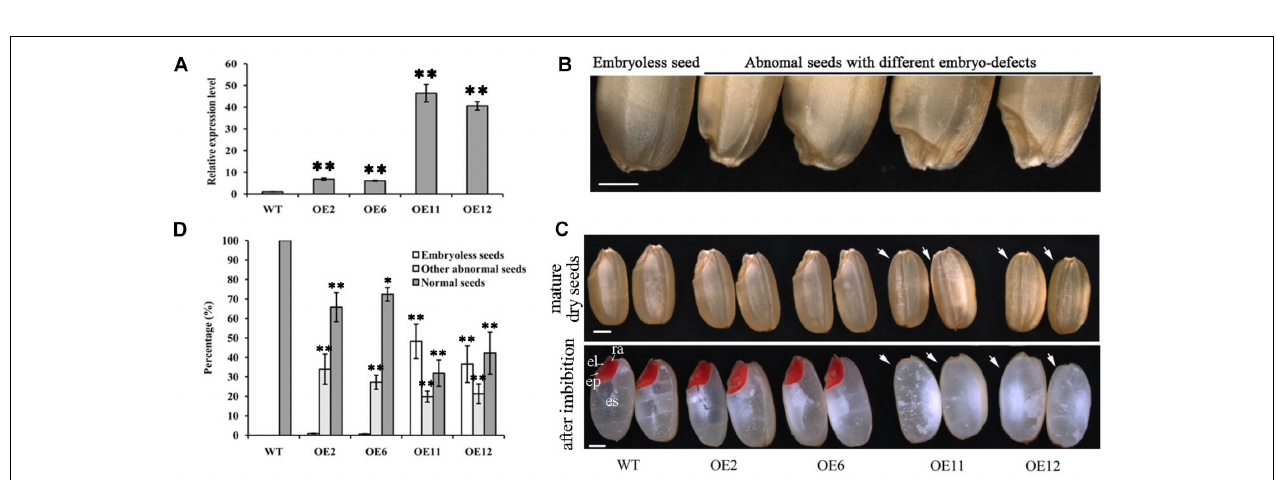
FIGURE 3 | Phenotypic analysis of seeds overexpressing OsGrxC2.2 . (A) qRT-PCR analysis of OsGrxC2.2 expression in the four independent transgenic lines OE2, OE6, OE11, and OE12. (B) Seeds with different types of embryo. (C) Embryo phenotype of the WT and OsGrxC2.2 overexpression lines. Upper panel, mature embryos from dry seeds; lower panel, TTC staining of rice seeds with imbibition at 12 h. cp, coleoptiles; el, embryonic leaves; ra, radical; arrow, embryos. Bars = 1 mm. (D) Percentage of different types of embryos in the WT seeds and OsGrxC2.2 -overexpression line seeds. Error bars show the standard deviation. Statistical significance is indicated by ∗∗ p < 0.01 and ∗ p <